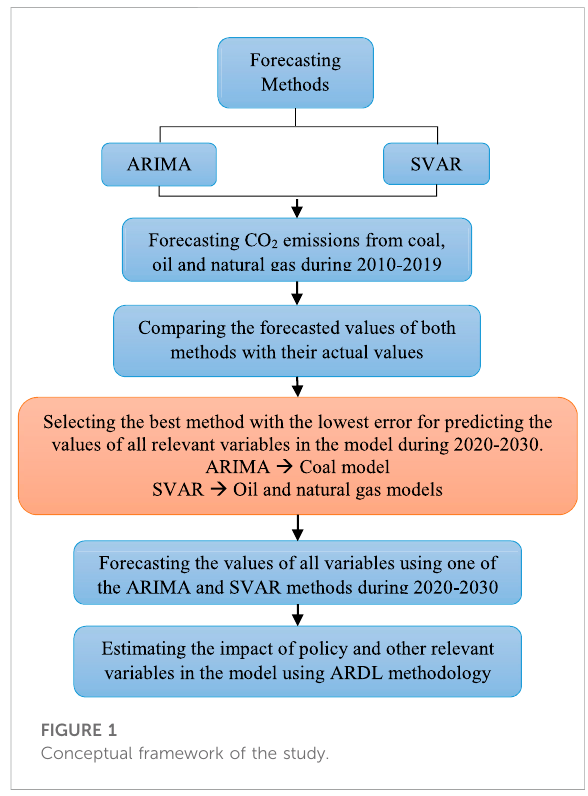
FIGURE 1 Conceptual framework of the study.